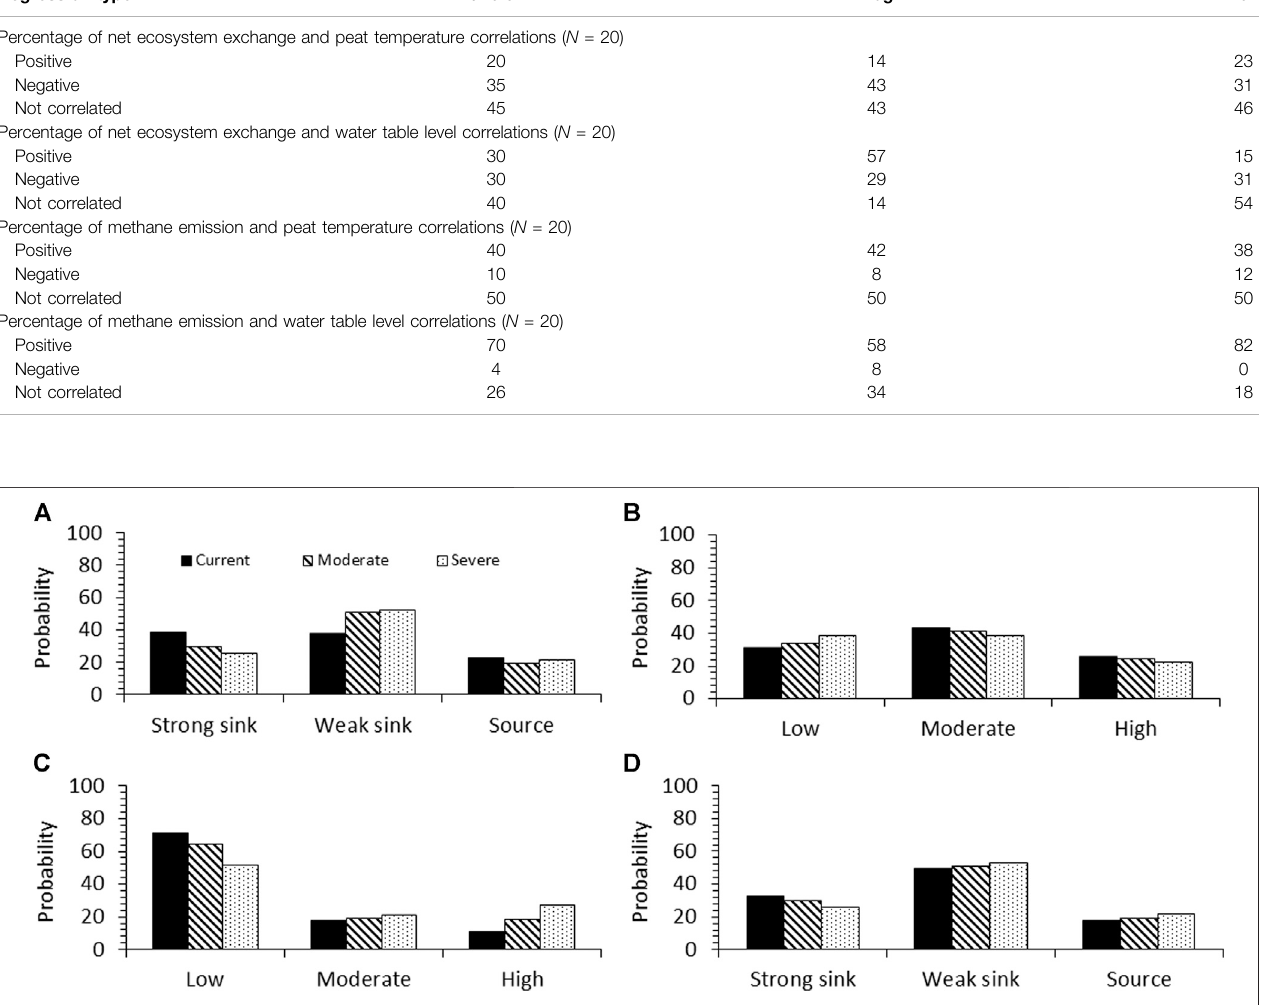
TABLE 3 | Percentages of net ecosystem exchange or methane correlations with peat temperature in the upper 0.3 m and water table level for overall peatlands, bogs, and fens calculated from 20 peatlands in the boreal and subarctic regions analyzed from the literature. Regression type Overall